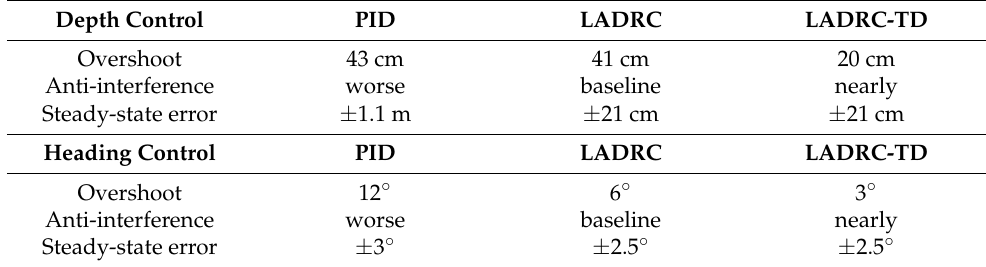
Table 2. Result summary of each